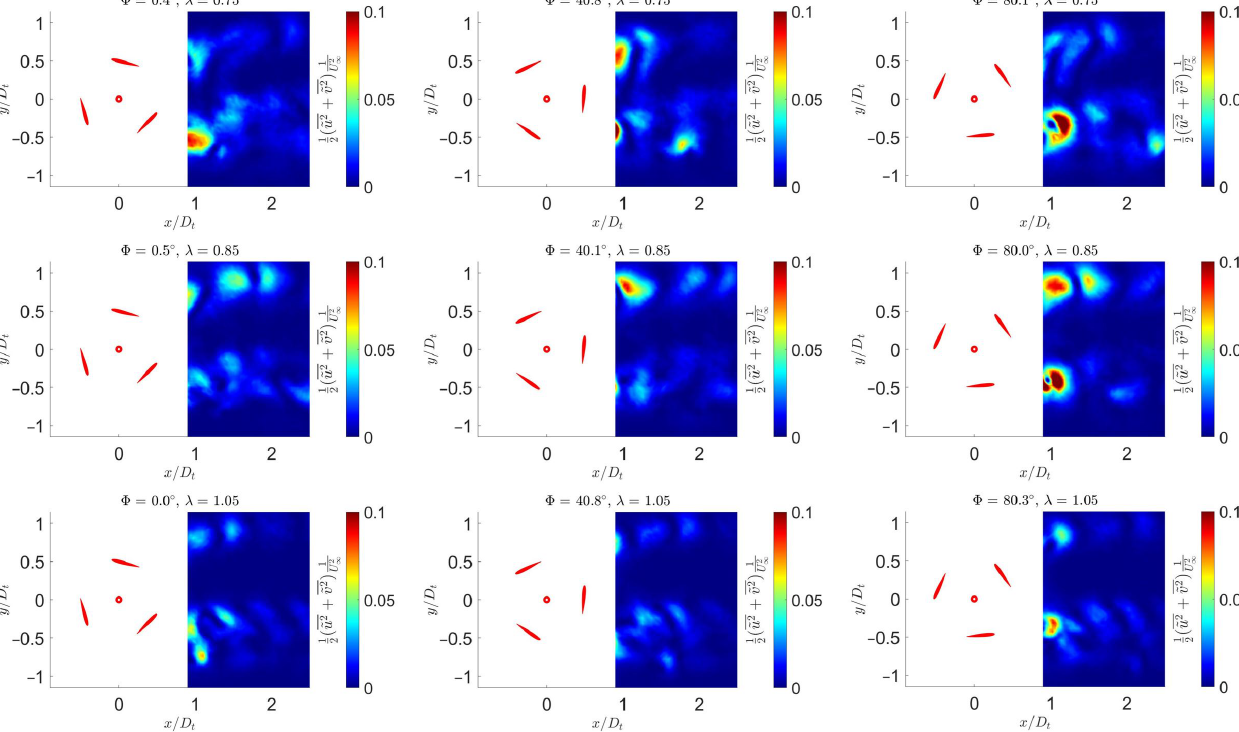
Figure 15. The fluctuating component of the phase-averaged kinetic energy of the flow behind turbine T1 at various phase angles and tip–speed ratios. The red circle displays turbine T1 rotation